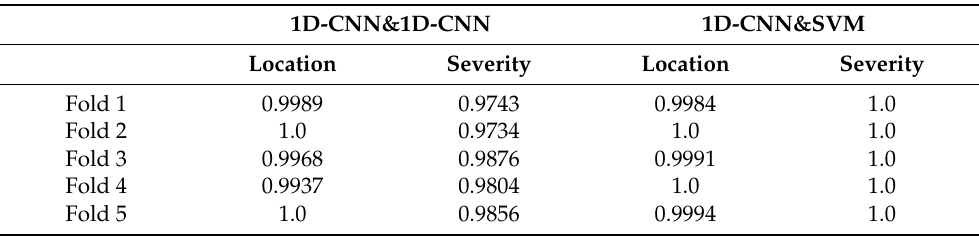
Table 4. Comparison of 1D-CNN and 1D-CNN with 1D-CNN and SVM in two-stage classifica- tion